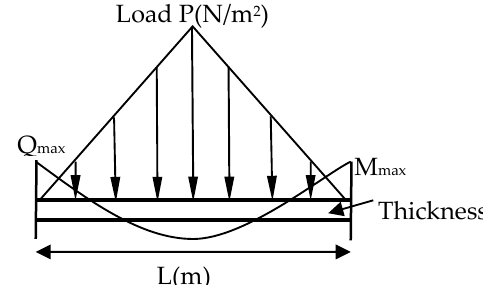
Figure 14. Bending failure resistance.